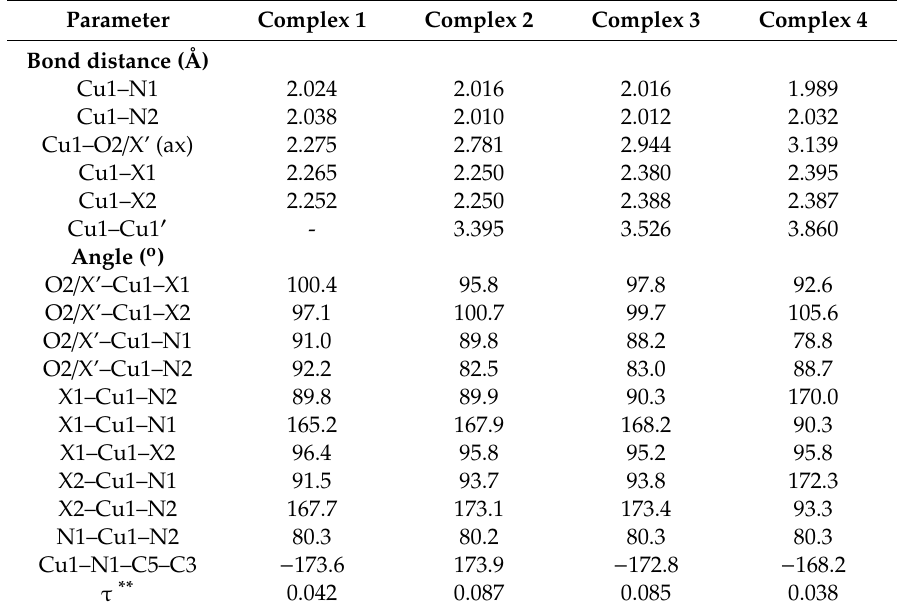
Table 1. Important geometry parameters for complexes 1 – 4